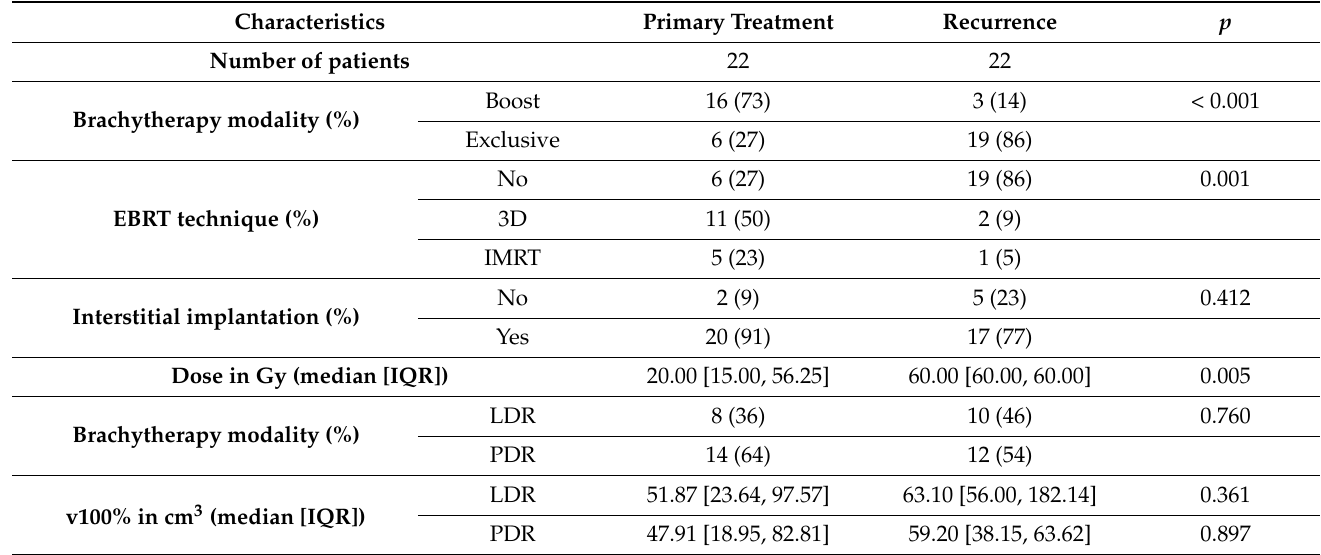
Table 2. Treatment characteristics according to patient